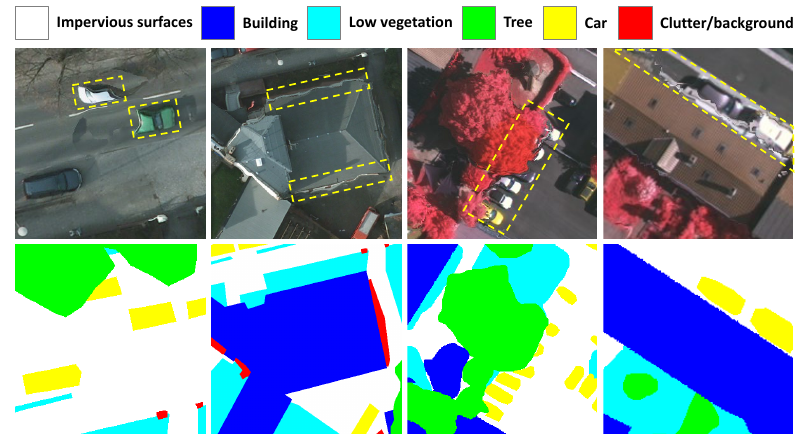
Figure 7. Examples of uncertain edge definitions.